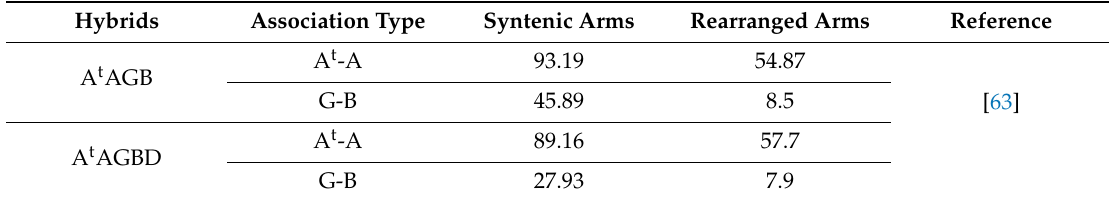
Table 2. Average frequency (%) of association at metaphase I between syntenic and rearranged chromosome arms of the A and A t genomes and the B and G genomes in T. timopheevii × T.